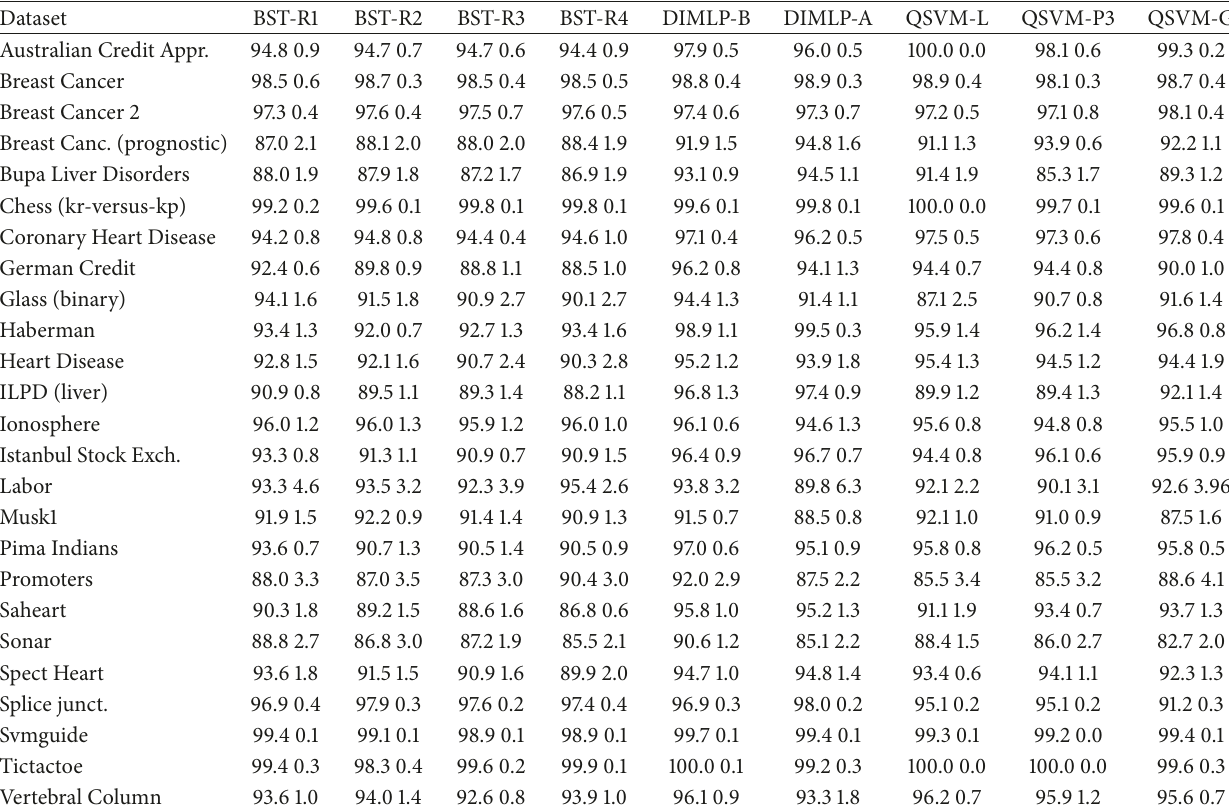
Table 9: Average fidelity and standard deviations of the extracted rules for BST-R, DIMLP ensembles, and QSVMs.